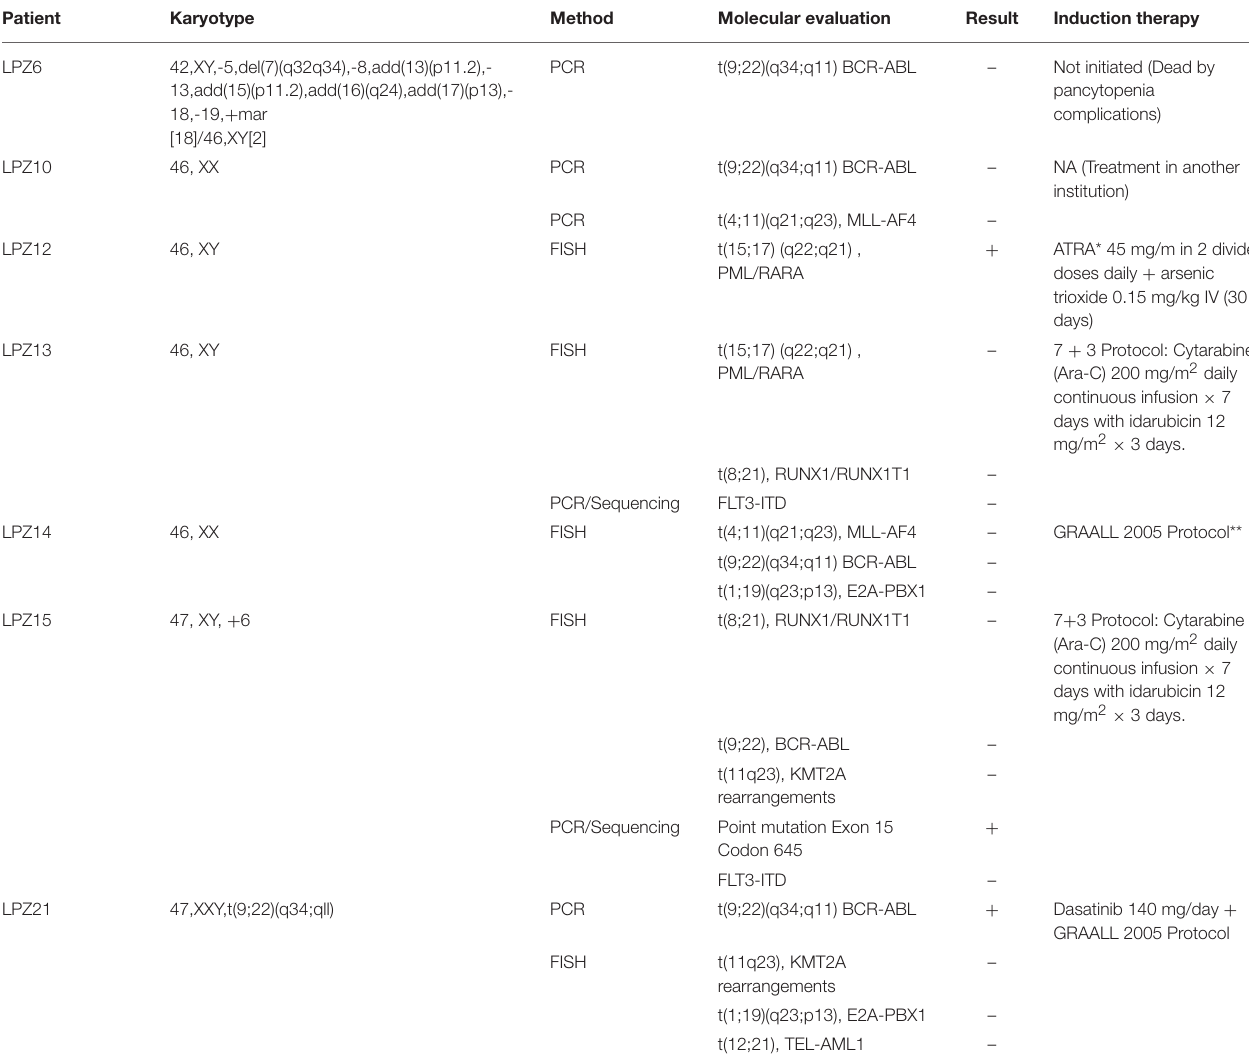
TABLE 2 | Molecular data and induction treatments of patients diagnosed with acute leukemia at Fundación Santa Fe de Bogota.